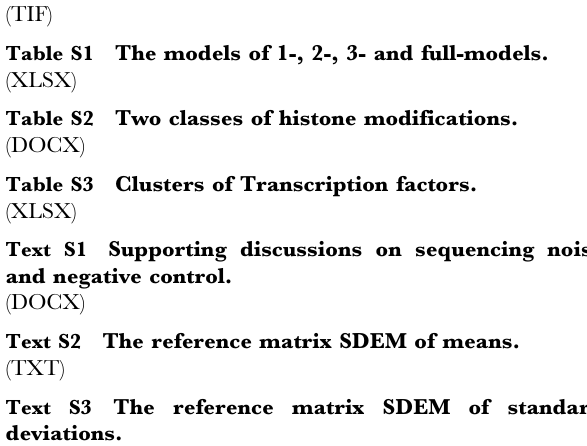
Figure S6 Predictive power of 2-models. Table S1 The models of 1-, 2-, 3- and full-models. Table S2 Two classes of histone modifications. Table S3 Clusters of Transcription